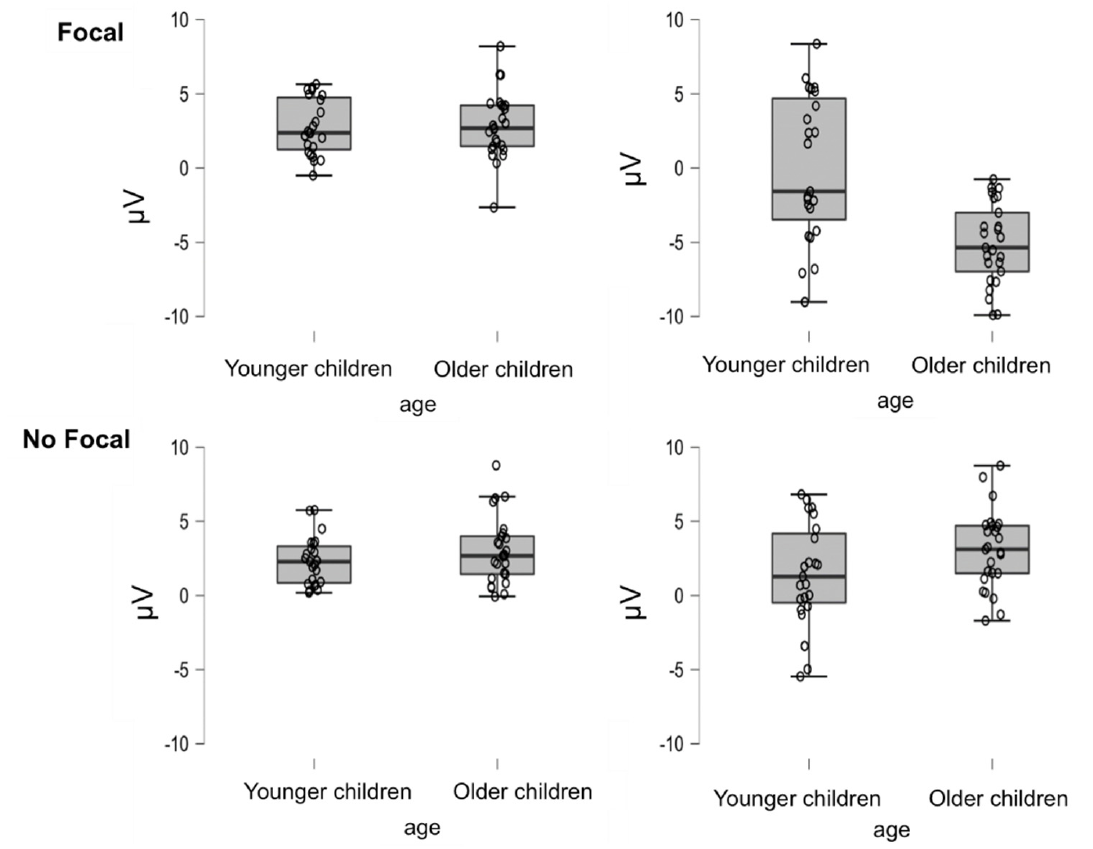
Figure 5. Box plots of the amplitude of the N300 component as a function of age, focality and type of